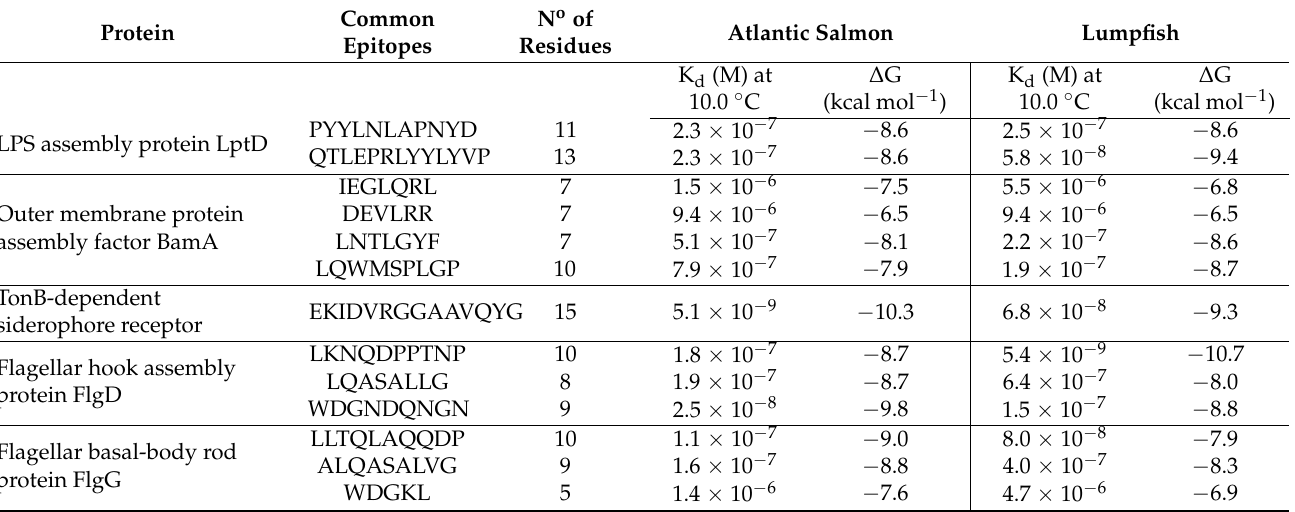
Figure 7. Sequence alignment showing domains harboring common epitopes across the bacterial pathogens studied. ( A ) LPS assembly protein LptD; ( B ) outer membrane protein assembly fac- tor BamA; ( C ) TonB-dependent siderophore receptor; ( D ) flagellar hook assembly protein FlgD; ( E ) flagellar basal-body rod protein FlgG. Table 5. Common epitopes identified in the five bacterial pathogens and their binding affinities and dissociation constants to Atlantic salmon and Lumpfish MHC